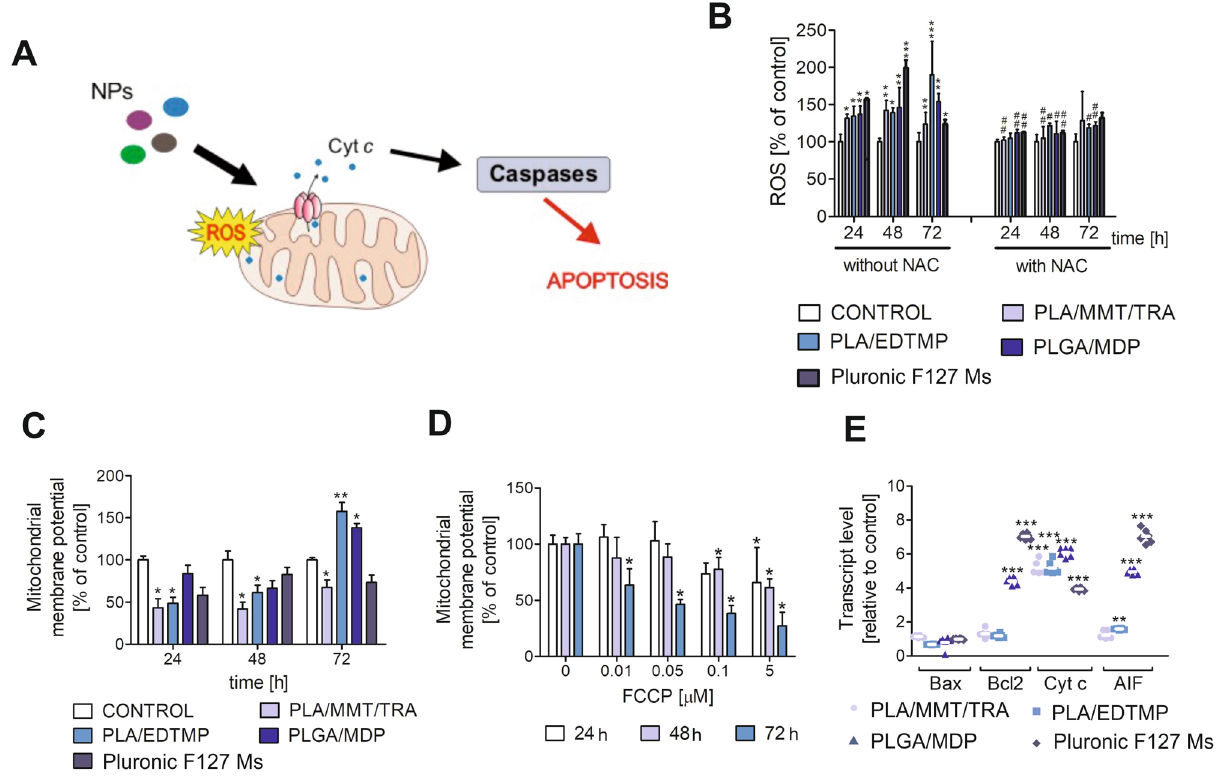
Figure 6. Mitochondrial stress triggered by NPs in HUVEC-STs. ( A ) Schematic overview of perturbations in mitochondrial functions, which may occur after NP treatment. ( B ) ROS production in cells treated with NPs (100 μg/mL of PLA/EDTMP, PLGA/MDP, and PLA/MMT/TRA or 0.025 μg/mL of Pluronic F127 Ms) for 24, 48, and 72 h. DCF fluorescence intensity in control cells was set to 100%. Each value represents average ± SD of four independent experiments, *p < 0.05, **p < 0.01, and ***p < 0.001 for significant differences compared to control cells, # p < 0.05, ## p < 0.01 for significant changes compared to samples preincubated with NAC and subsequently incubated with nanosubstances. ( C , D ): Changes in mitochondrial membrane potential of HUVEC-STs seeded into black 96-well titration microplates and incubated with NPs (100 μg/mL of PLA/ EDTMP, PLGA/MDP, and PLA/MMT/TRA or 0.025 μg/mL of Pluronic F127 Ms) for 24, 48, and 72 h ( C ) or FCCP ( D ). Fluorescence ratio of JC-1 dimers to JC-1 monomers in control was assumed to be 100%. Results are presented as means ± SD of four experiments. *p < 0.05, **p < 0.01 for significant differences between NP-treated and untreated control cells (taken as 100%); ( E ) Bax, Bcl2, Cyt c, and AIF gene transcript expression (relative to HPRT1 housekeeping gene) in HUVEC-STs exposed to examined nanosubstances: PLA/EDTMP, PLGA/MDP, and PLA/MMT/TRA (100 μg/mL) or Pluronic F127 Ms (0.025 μg/mL). Asterisks refer to level of significant (**p < 0.01, ***p < 0.001; n = 3) difference in expression in cells treated with investigated NPs compared to untreated